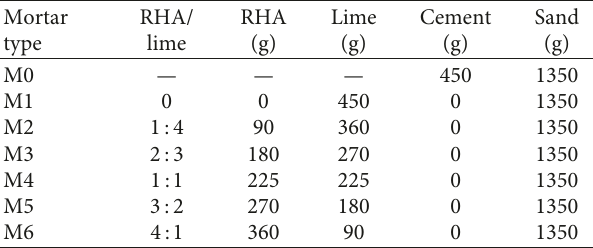
Figure 7: Microstructure of lime. Table 3: Mortar composition in parts by weight.